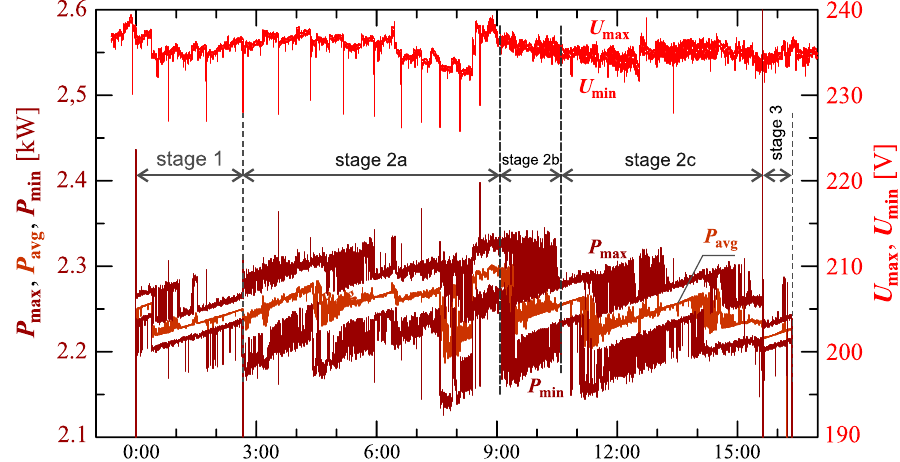
Figure 35. The characteristic of maximum P max = f ( t ) , average P avg = f ( t ) and minimum P min = f ( t ) values of active power and maximum U max = f ( t ) and minimum U min = f ( t ) rms values of supply voltage for Case